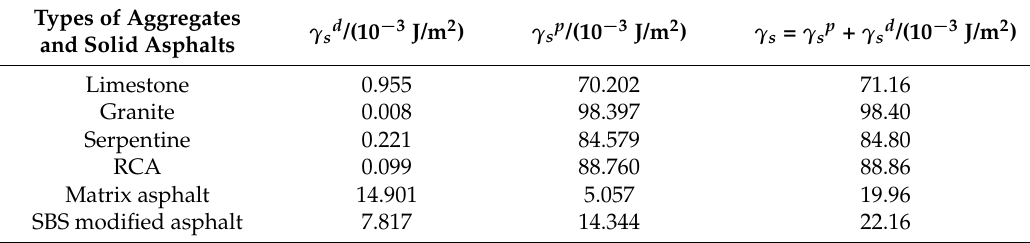
Table 7. Surface energy of aggregates and solid asphalts.